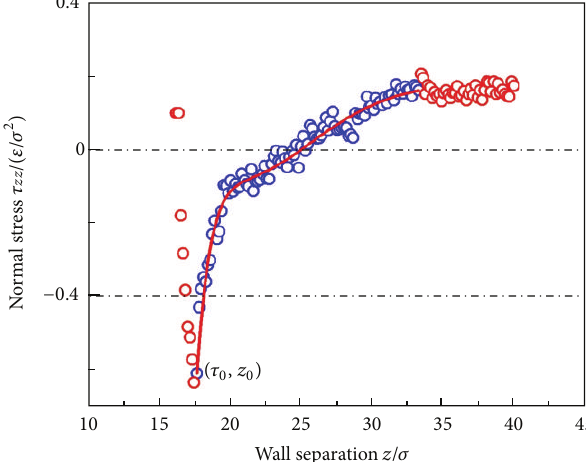
Figure 40: The nonlinear square fit of normal stress data using (19) for nonfunctional PFPE ( 𝜀 𝑝 𝑏 = 𝜀 𝑝 𝑤 = 0 ) films.